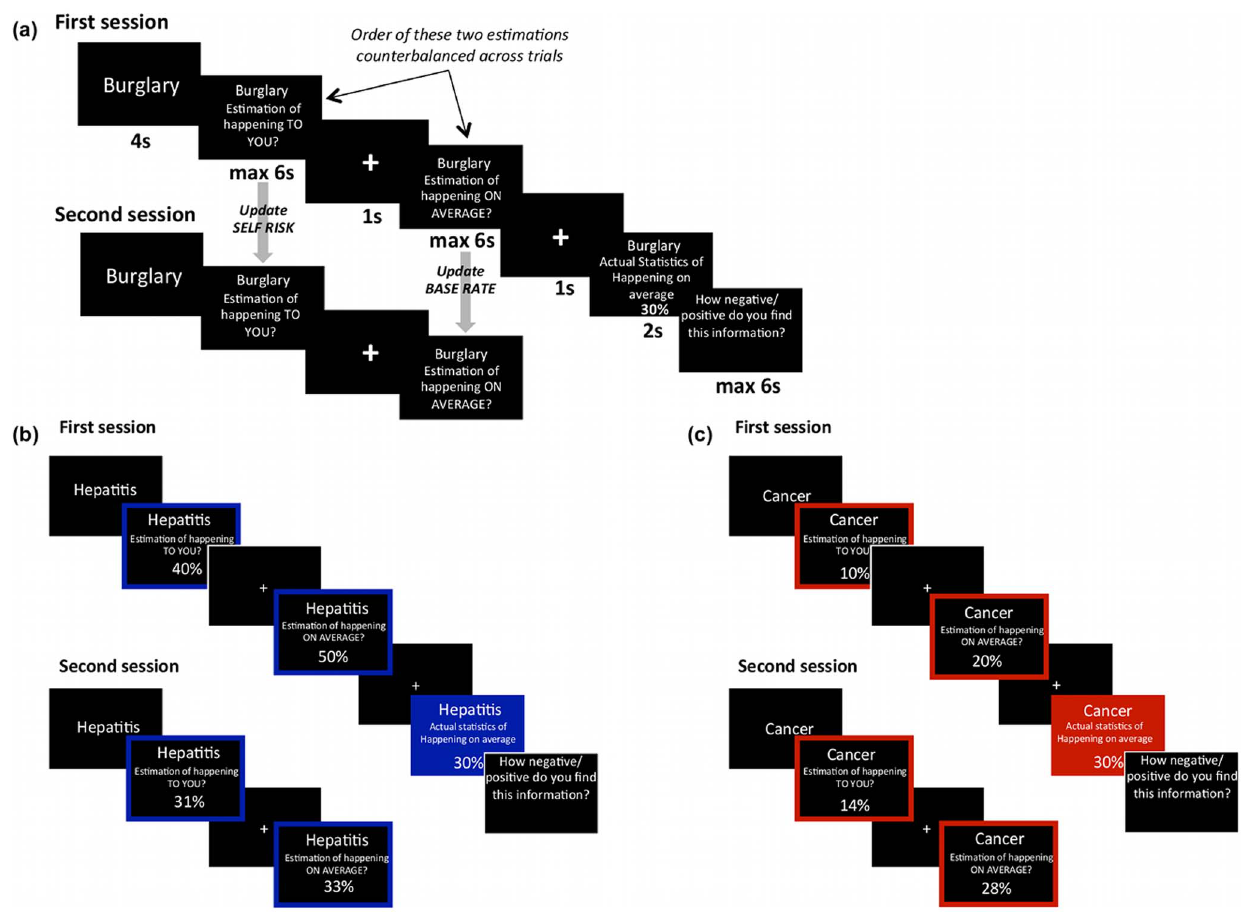
Figure 1. Paradigm. (a) In each trial, participants were presented with a short description of 1 of 80 adverse events and asked to estimate how likely this event was to occur to themselves in the future and how likely the event was to happen on average in the population. They were then presented with the base rate in a demographically similar population. Finally, participants were asked to rate how negative/positive they found this information. The second session was the same as the first except that the base rate was not presented and participants did not submit any ratings. Examples of trials in which the participant’s estimate of the event occurring to themselves and the base rate was (b) higher or (c) lower than the provided base rate. In the specific examples shown here, under either classification scheme therefore these trials would be categorized as desirable and undesirable trials respectively.